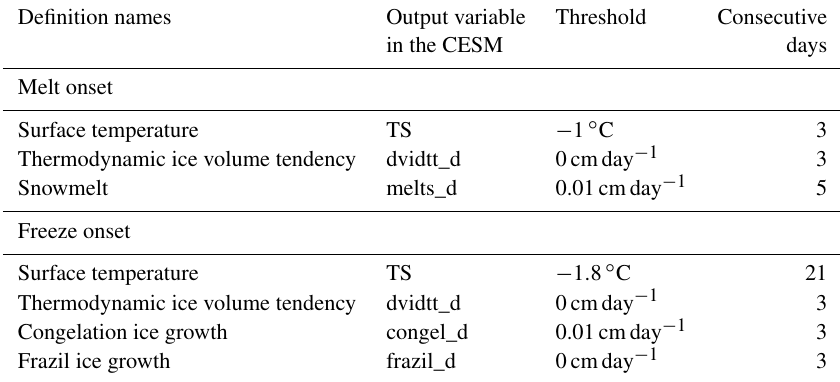
Table 1. CESM LE definitions for melt and freeze onset, showing the model output variable name used, the threshold used and the number of consecutive days over which the variable must exceed the threshold for each definition. Details on how these thresholds and consecutive days were chosen can be found in the